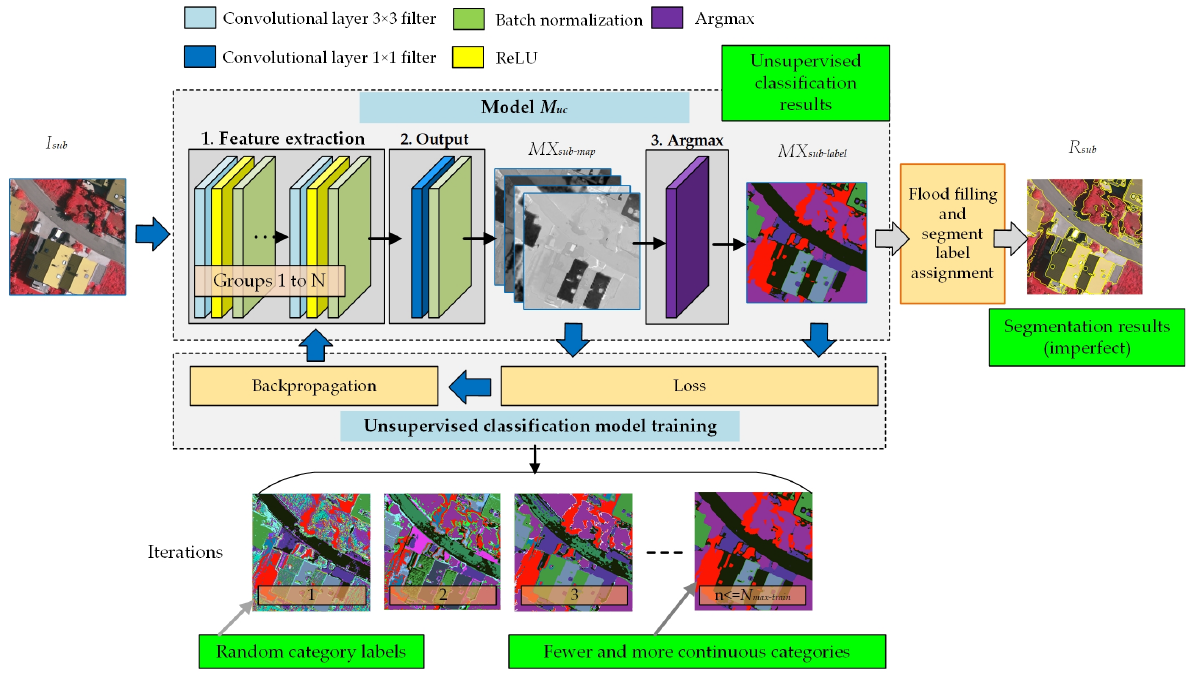
Figure 3. Unsupervised deep neural network structure and segmentation process.